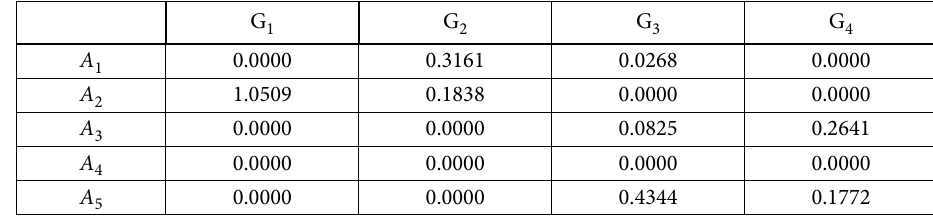
Table 6. The results of PDA ij